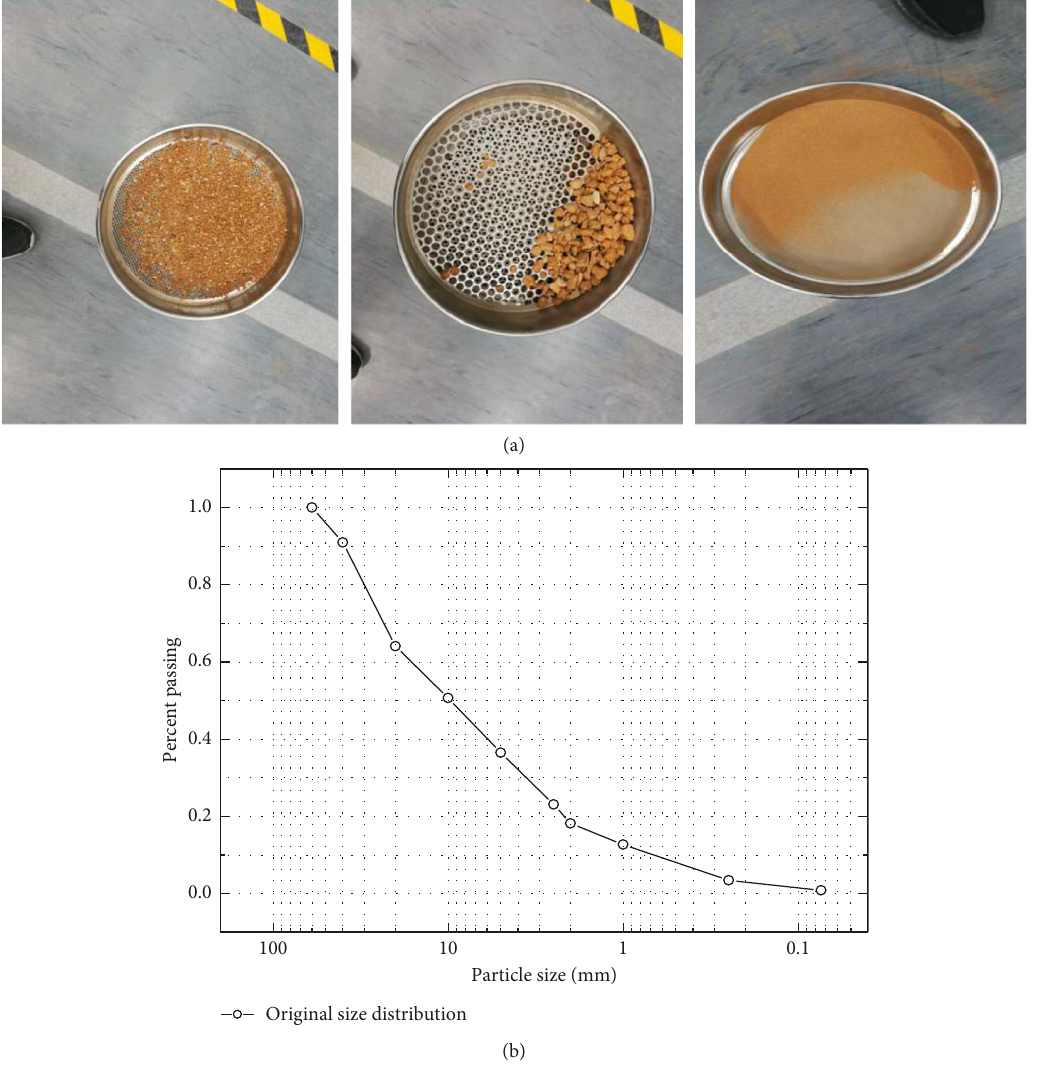
Figure 1: (a, b) Typical component and particle size distribution of